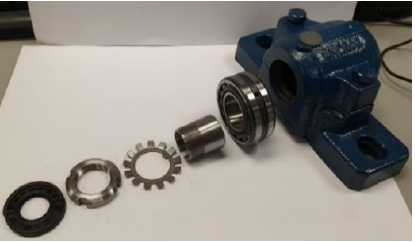
Figure 7. Dismantling of the test set.